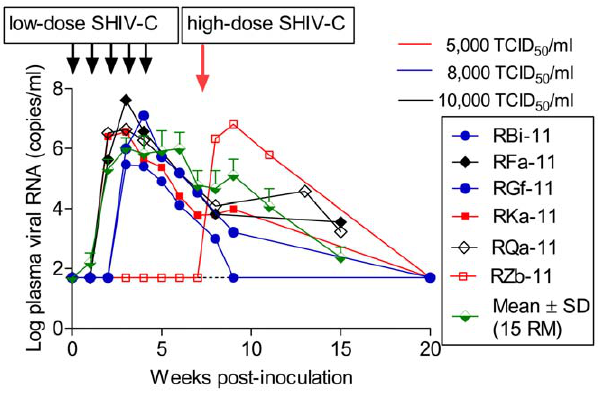
Figure 7. Intrarectal inoculation of SHIV-1157ipEL-p. Six monkeys were used in a repeated low-dose i.r. titration; the aim was to find a virus dose that resulted in systemic infection (defined as viral RNA $ 10 4 copies/ml) after a maximum of five weekly i.r. inoculations. RM remaining uninfected at week 2 after the 5 th weekly low-dose virus challenge were given a single high-dose of SHIV-1157ipEL-p (1.5 6 10 5 TCID 50 ). The green half-diamonds represent mean 6 SD of 15 additional RM used in unpublished vaccine efficacy studies as unvaccinated controls; these animals were given maximally five weekly i.r. inoculations at 8,000 TCID 50 . The horizontal dotted line indicates lower limit of detection ( , 50 viral RNA copies/ml).